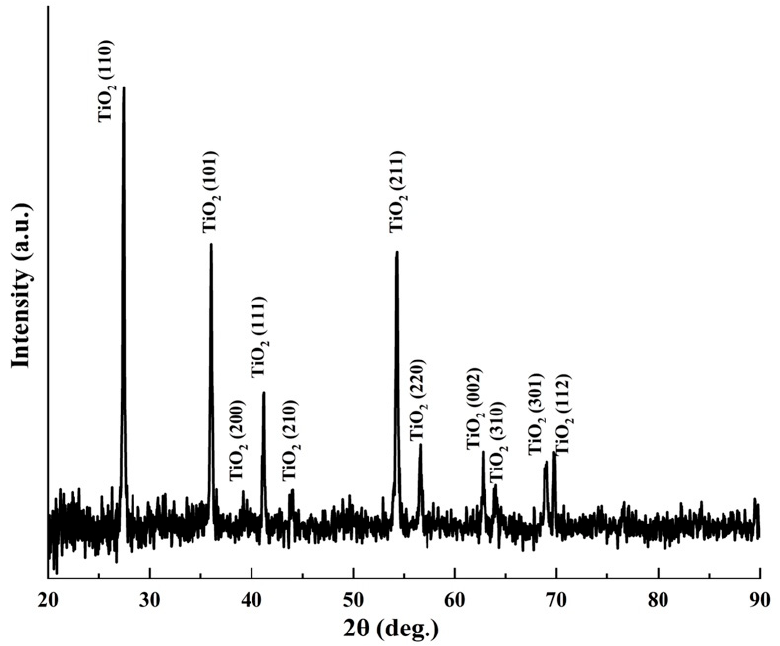
Figure 2. XRD analysis of TiO 2 grown on Ti mesh via the hydrothermal method.